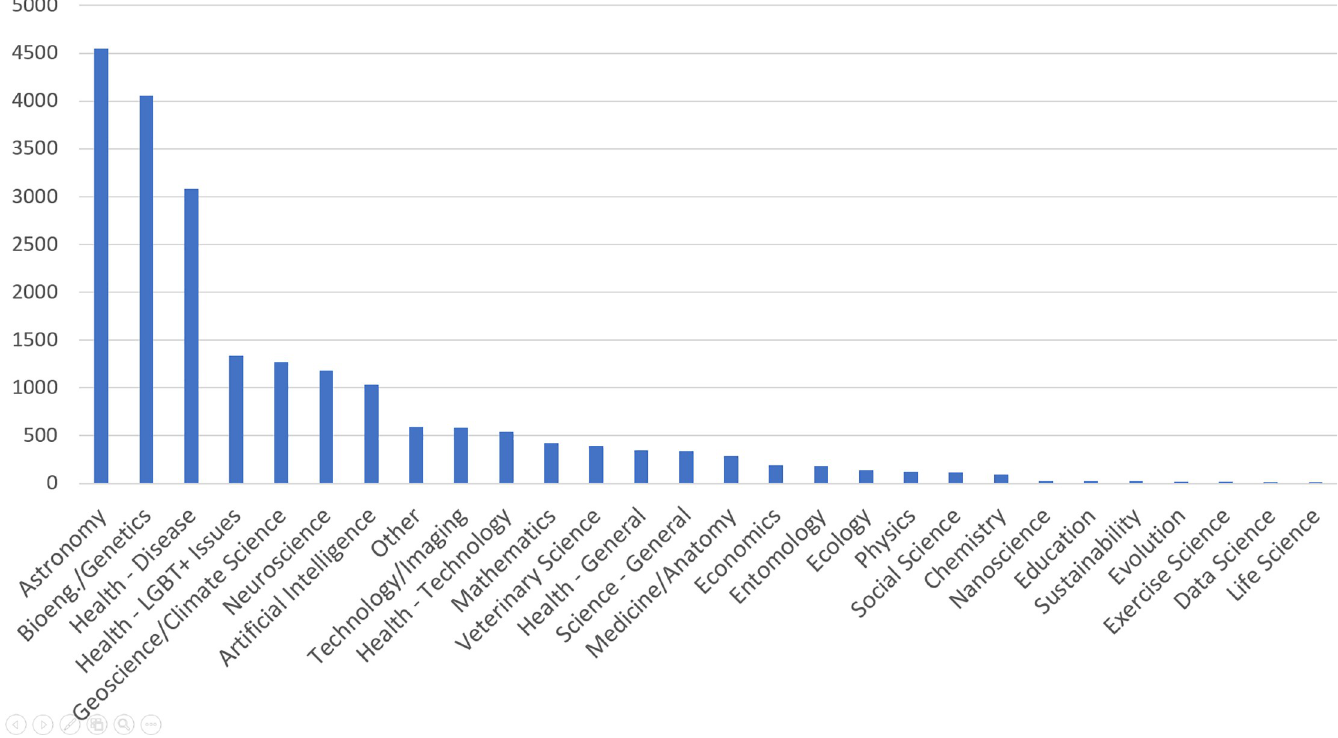
Fig 1. Number of r/science AMAs from each discipline between June 13, 2017 and April 30, 2018 (n = 250).